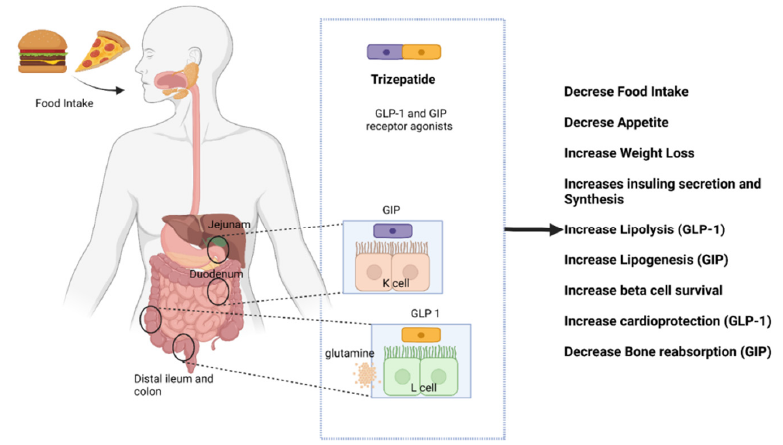
Figure 4. Mechanisms of action of tirzepatide within the human body.